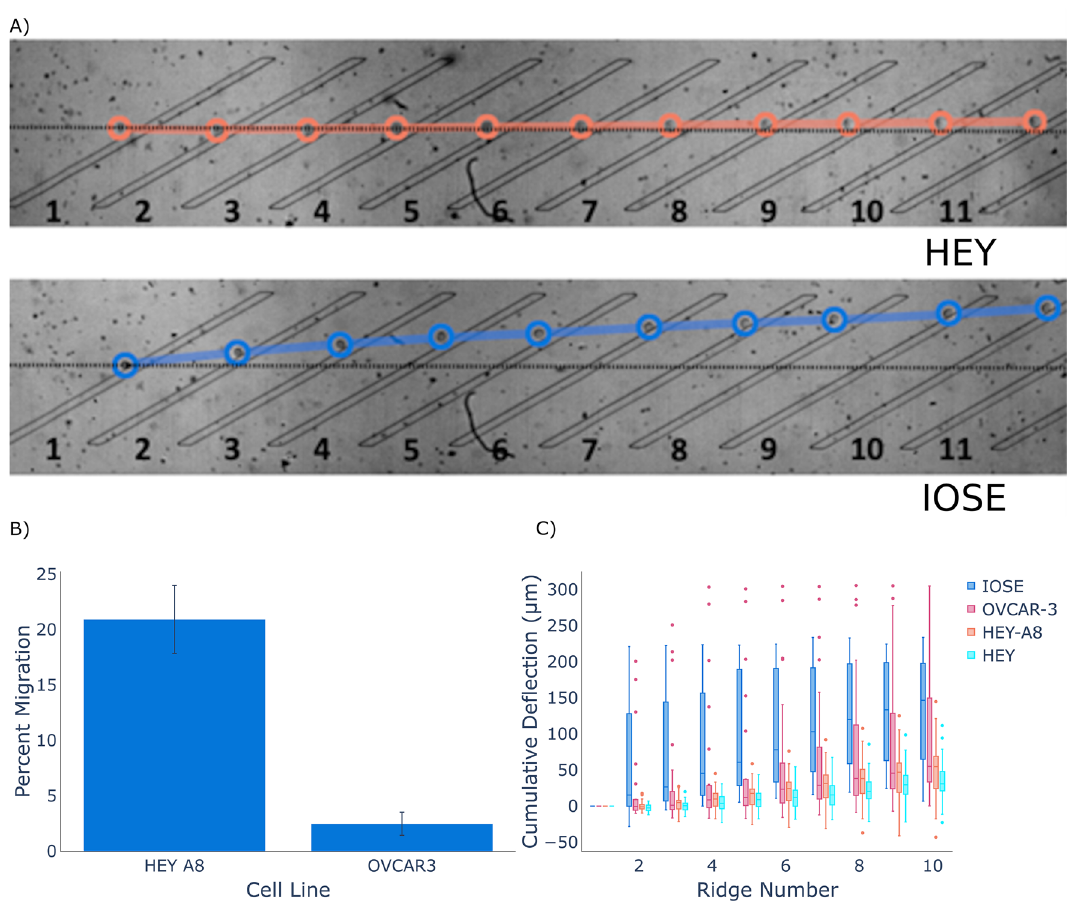
Figure 3. Trajectory analysis of ovarian cancer cell lines. ( A ) Characteristic trajectories of a metastatic ovarian cancer cell line (HEY) versus a nonmetastatic ovarian cancer cell line (IOSE) ( B ) Migration assay showing the relative invasiveness of the HEY and OVCAR-3 cell line. ( C ) The trajectories of a variety of ovarian cancer cell lines analyzed to show the cumulative cell deflection at each ridge. Cells with a lower metastatic ability (IOSE, OVCAR3) deflected more than cells with a higher metastatic ability (HEY, HEY-A8). The videos used for this analysis are provided as Supplemental